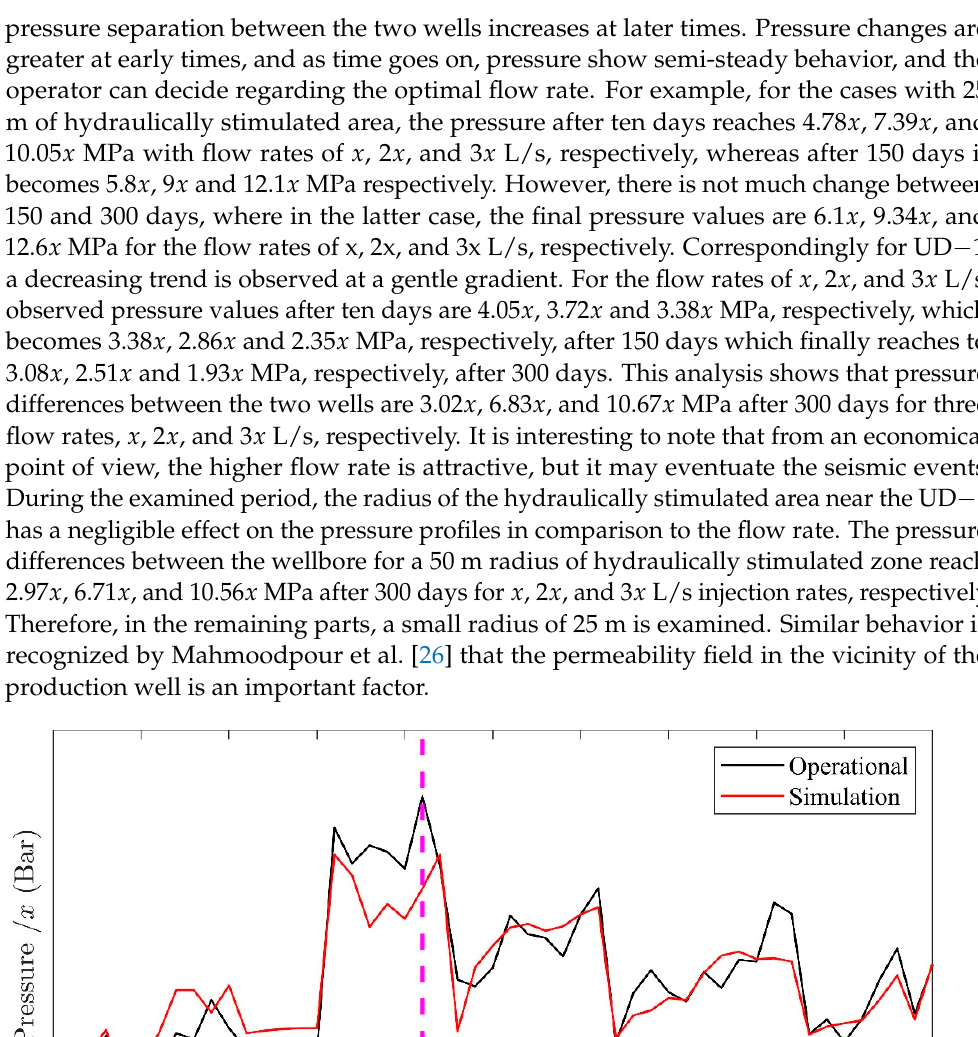
The obtained permeability field through the UD − 1 well data is validated with the hydraulic testing and stimulation data of well UD − 2. Figure 9 demonstrates a good match between the operational data and numerical simulation of UD − 2 for the first three stages of injection. However, there is a discrepancy between the measured and modeled data, as shown in Figure 6 for 20 November. Based on this figure, the flow rate decreases to zero in the middle of the test and increases afterward. The operational data shows that the injection pressure increases following the initial trend without experiencing an impact due to the intermittent flow rate breaks. The numerical simulation for UD − 2, on the con- trary, shows that if the flow rate decreases only for a short time interval, pressure de- creases for the rest of the entire injection step and does not reach the previous pressure level. The observed low pressure after a short gap in the injection is not due to the perme- ability change. Rather the pressure diffuses inside the system leading to pressure drop. It, therefore, seems likely that the flow rate stops and pressure drops are rather a measure- ment error while reporting the pressure and flow rate data or that the wellbore effect [26] between the wellhead and the reservoir section mitigates the flow rate and pressure drops.